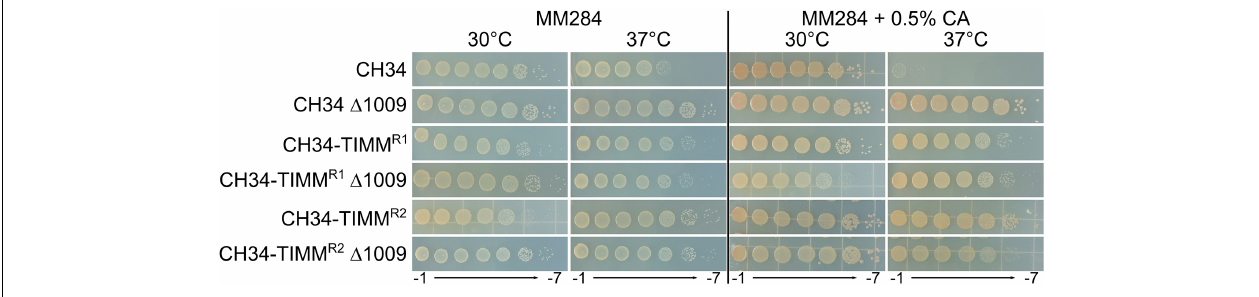
Supplementary Table 1 | Primers used in this